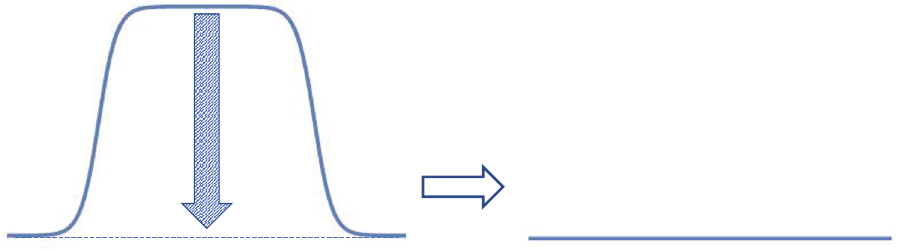
Figure 1 . A kink-antikink configuration is unstable, and will decay into the